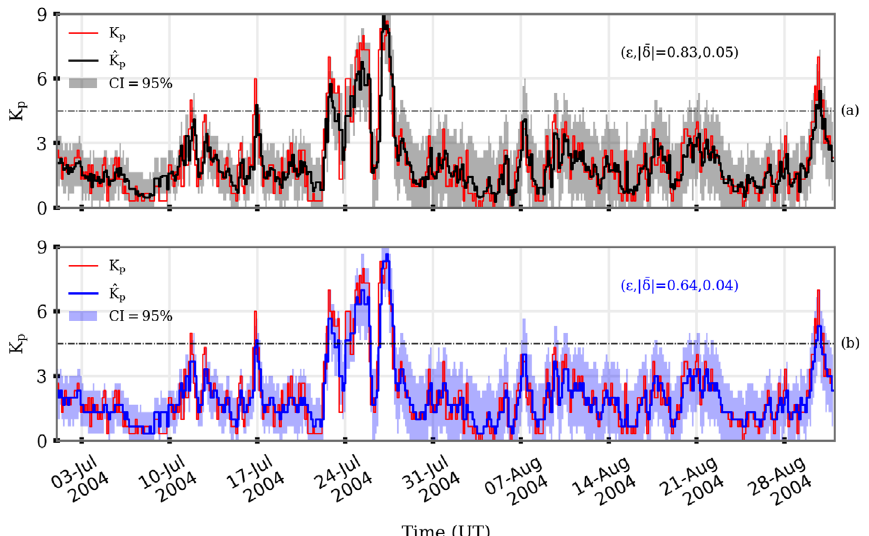
Fig. 7. Three-hour forecast of K p using LSTM classi fi er & Deep Gaussian Process Regression (Deep GPR) for a solar maximum period (1st July – 31st August, 2004). Panels: (a) prediction from the model using OMNI solar wind data and (b) prediction from the model using OMNI solar wind data and GOES solar fl ux data. Blue and black dots in panels (a) and (b) are mean predictions and red dots show observed K p , respectively. Light blue and black shaded regions in panels (a) and (b) respectively show 95% con fi dence interval. RMSE ( e ) and MAE ( j mentioned inside each panel.